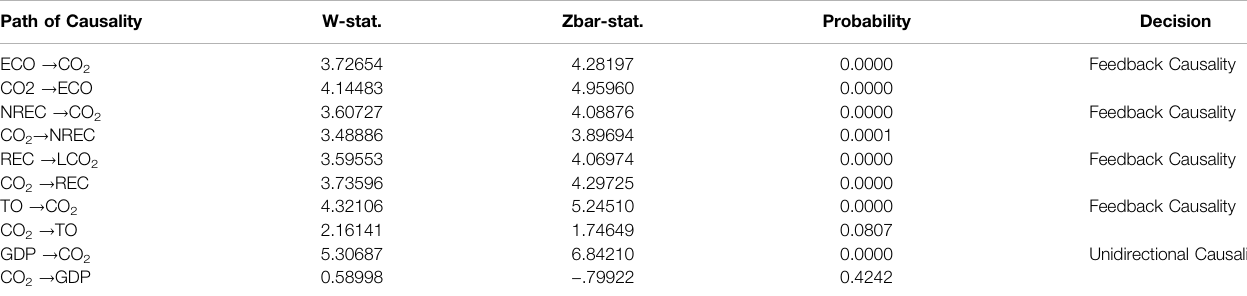
TABLE 9 | Panel causality